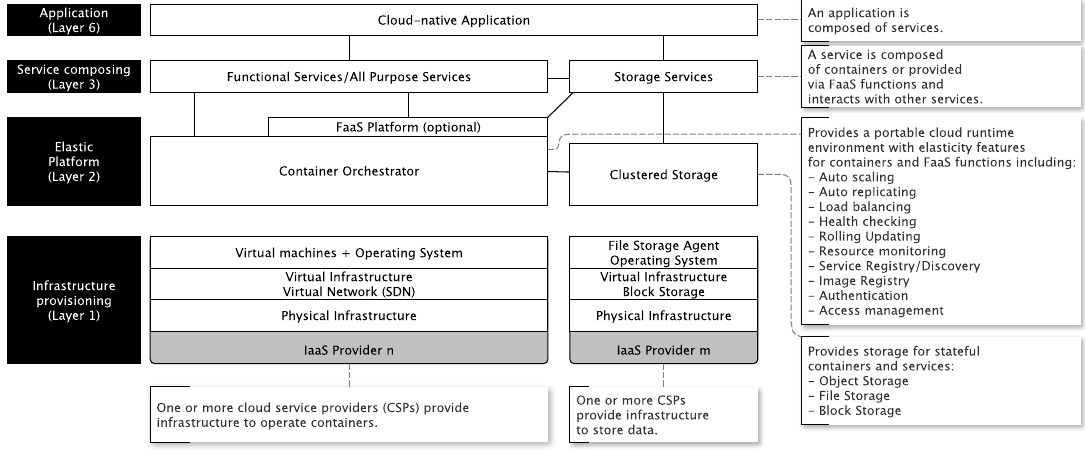
Figure 3. Cloud-native stack observable in a lot of cloud-native